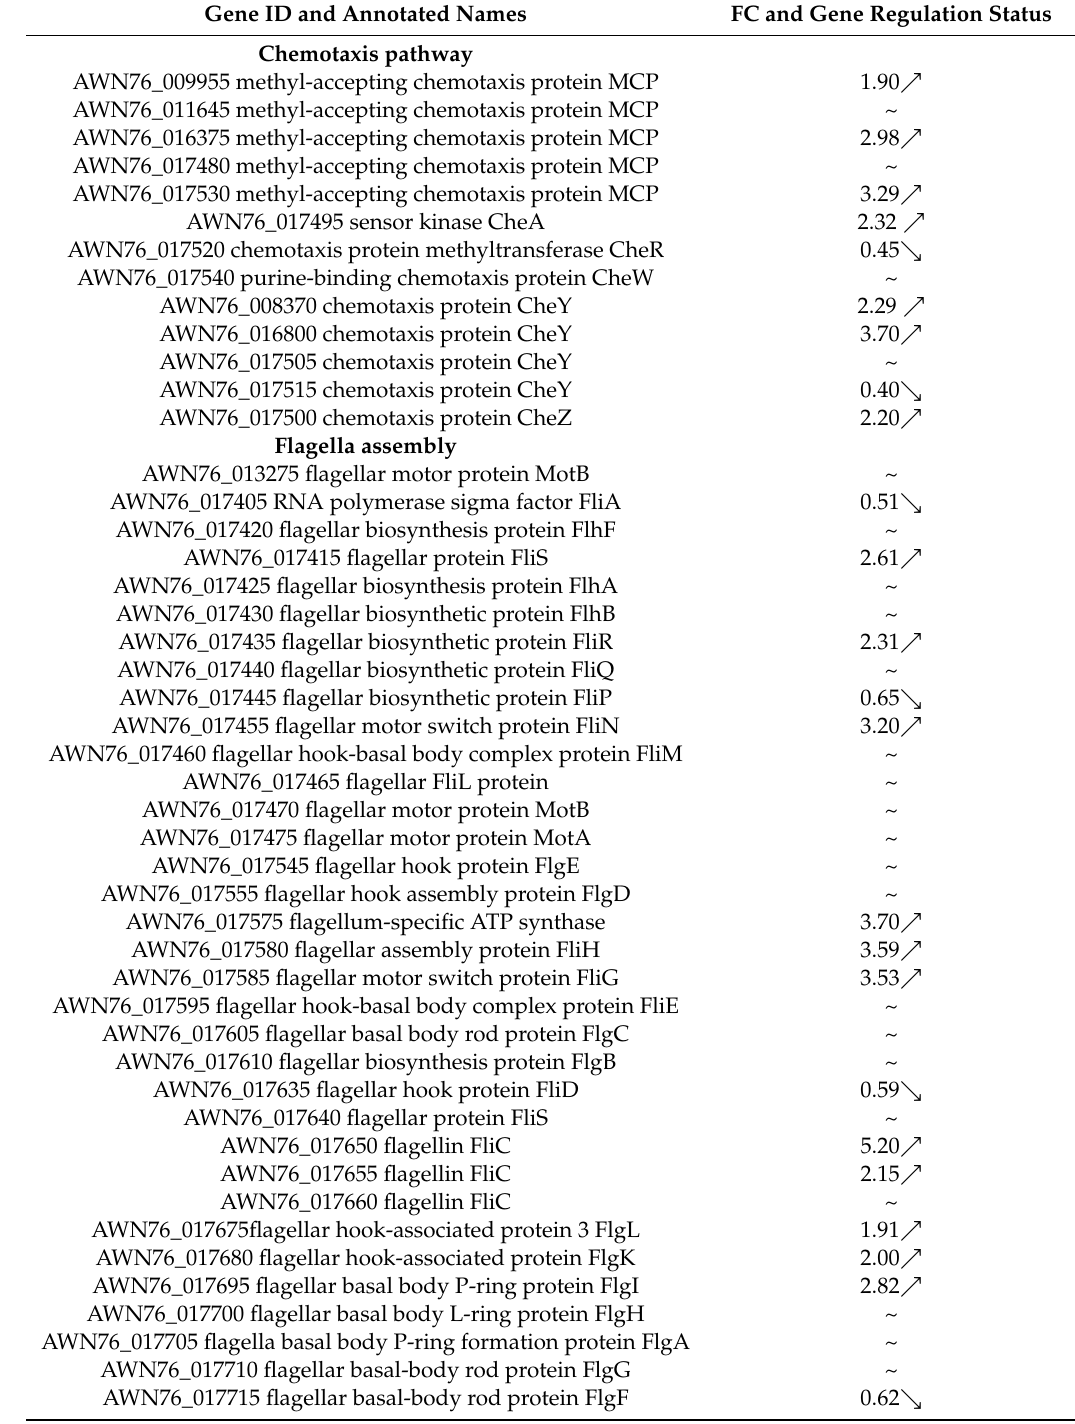
Table 4. Fold change of genes related to chemotaxis and flagella